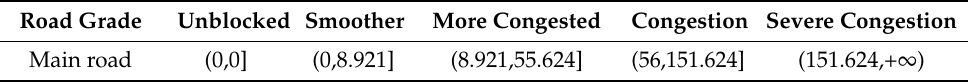
Table 2. Standard Table of Average Extension of Unit Mileage. Road